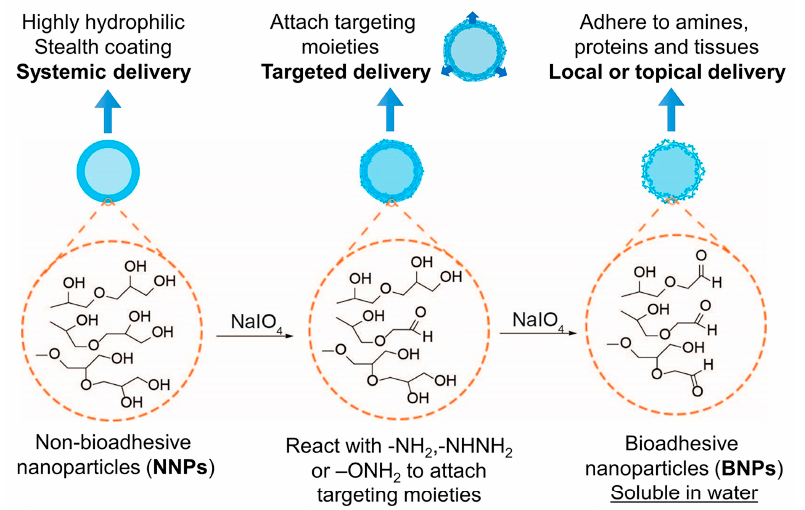
Figure 5. Synthetic schematic of the conversion of bioadhesive nanoparticles (BNPs) from non-bioadhesive nanoparticles